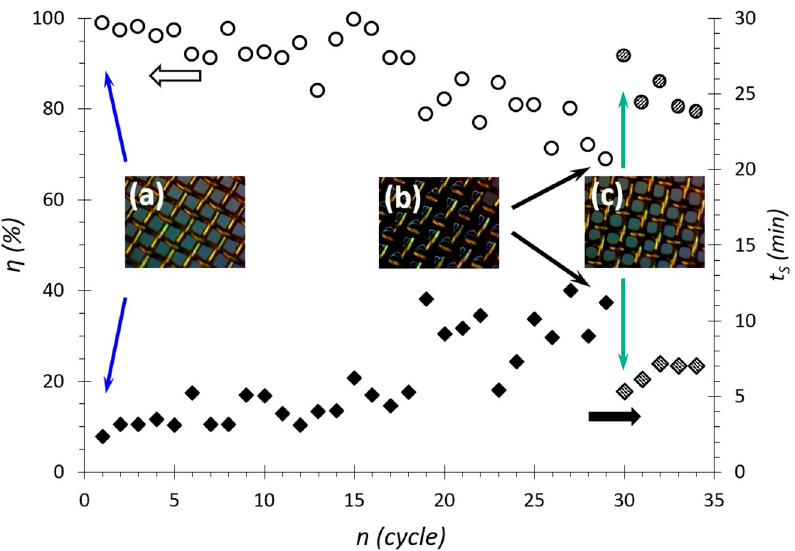
Figure 7. Dependences of efficiency and separation time on the number of separation cycles. In the inserts, the surface of ( a ) clean, ( b ) used, and ( c ) washed membranes. The arrows indicate the points where clean (blue arrows), used (black arrows) and washed (green arrows) were used.